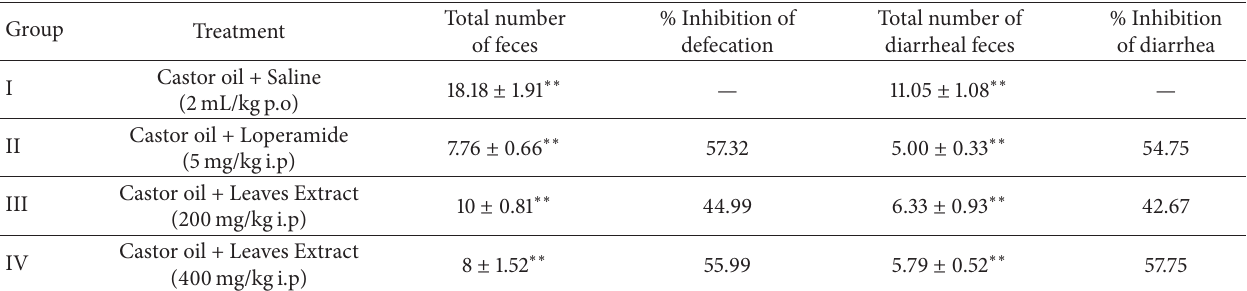
Table 1: Effect of MEMA leaves on castor oil-induced diarrhea in rats.